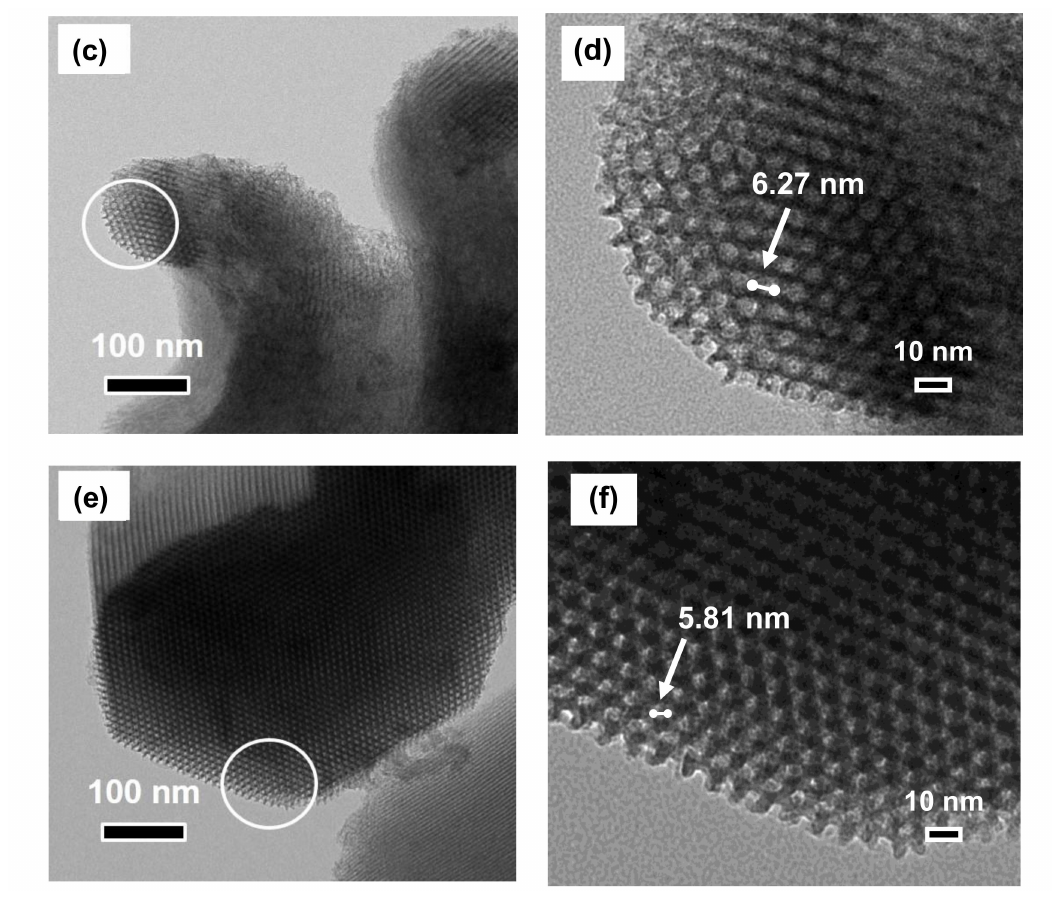
Figure 4. The TEM image of SBA-15 catalysts: ( a , b ) SBA-15-FA; ( c , d )